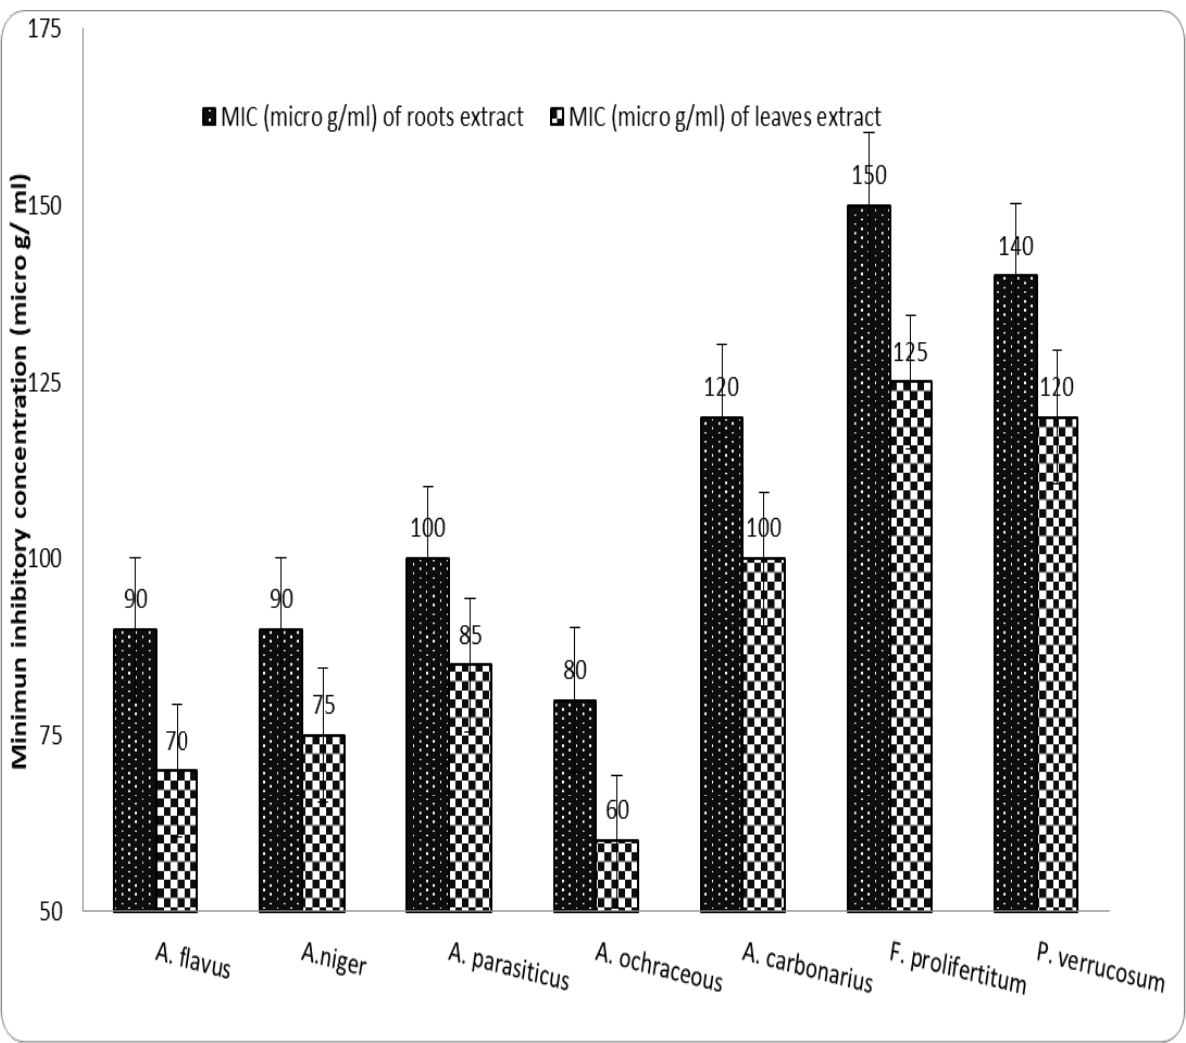
Figure 4. Minimum inhibitory concentration of Berberis vulgaris roots and leaf extracts for examined fungi.